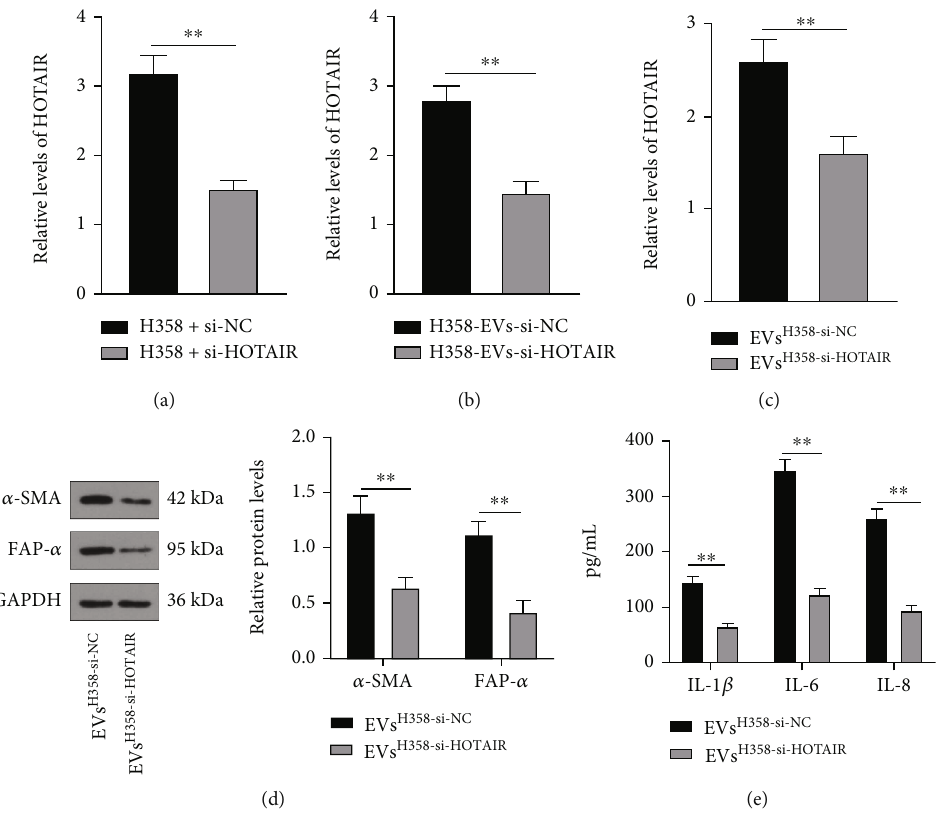
Figure 4: H358-EVs promoted the activation of CAFs by delivering HOTAIR. After transfection of H358 cells with HOTAIR inhibitor, EVs isolated and extracted were cocultured with NFs for 6 hours. (a – c) The levels of HOTAIR in H358 cells, EVs, and NFs were detected by RT- qPCR; (d) the protein levels of α -SMA and FAP- α on the surface of CAFs were detected by WB; (e) the levels of cytokines IL-1 β , IL-6, and IL-8 were detected by ELISA. Cell experiment was repeated three times, and the t -test was used for data comparison between groups. ∗∗ P < 0 : 01